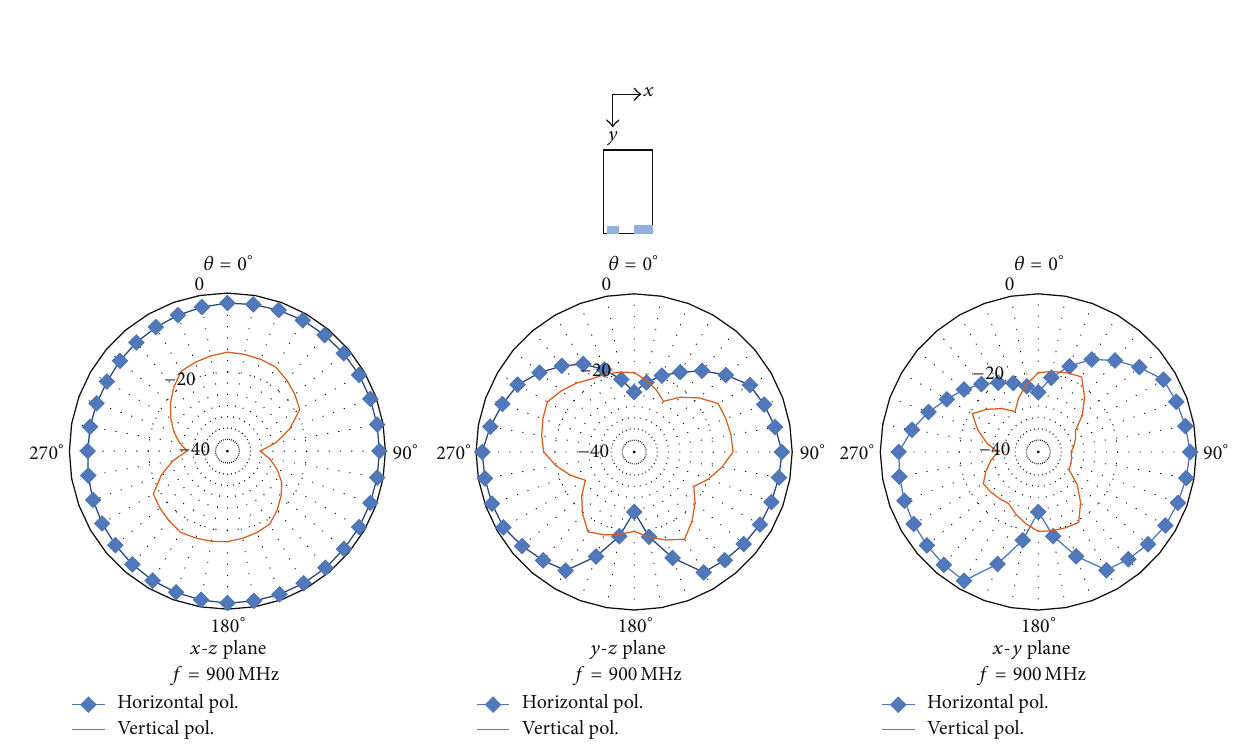
Figure 9: Radiation pattern of the proposed antenna at 900 MHz.